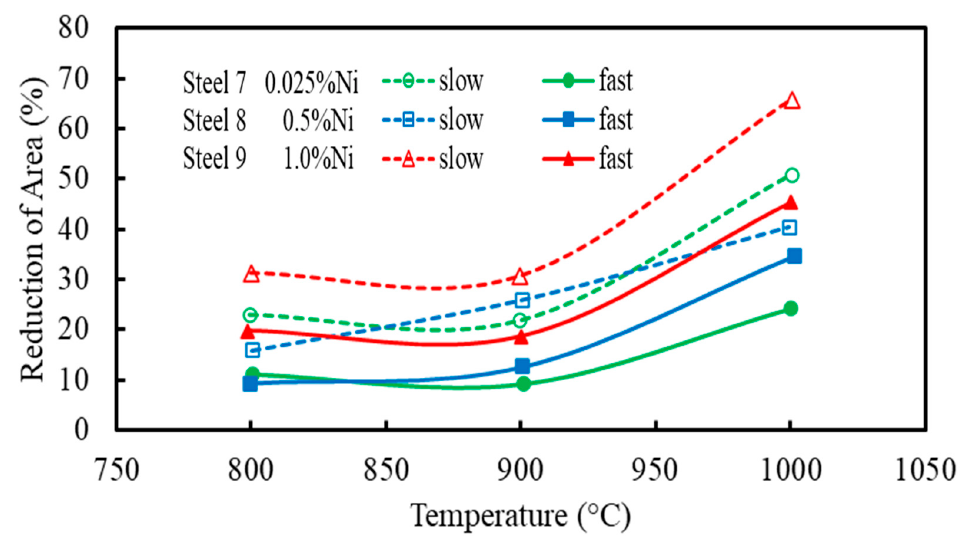
Figure 8. Hot ductility curves for Nb–Ti-containing steels with increasing Ni contents, 0.025%, 0.5% and 1%. Increasing the Ni content and decreasing the cooling rate improve the hot ductility by coarsening the carbo-nitrides [30].